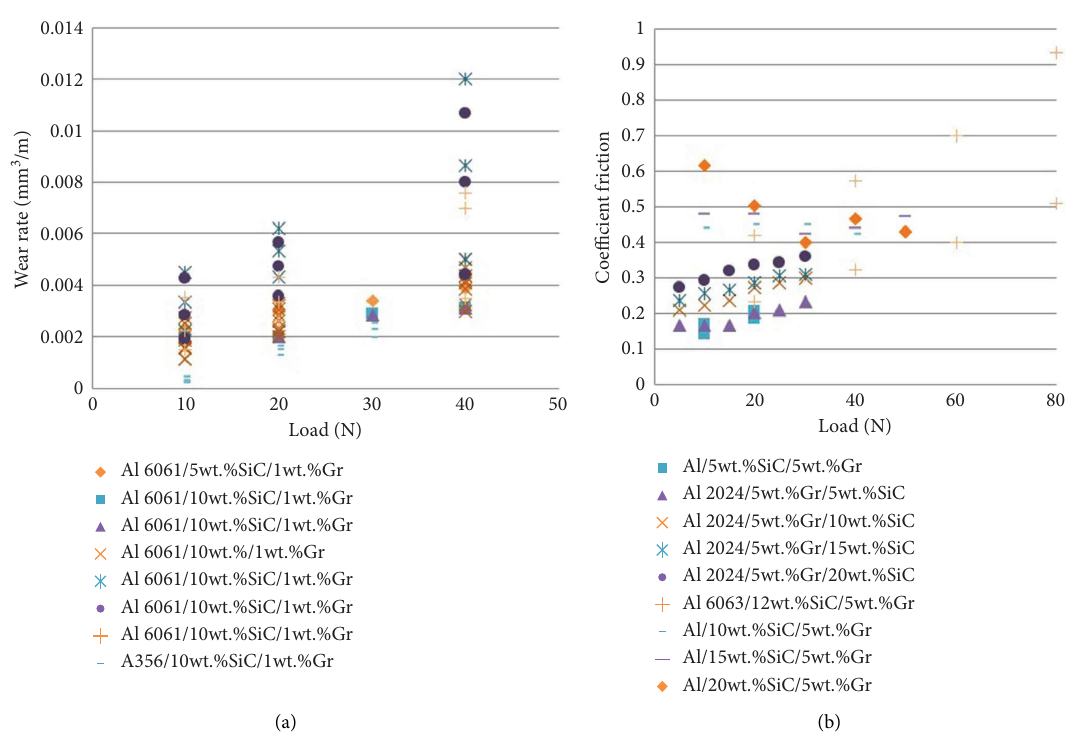
Figure 16: SEM micrographs of (a) monolithic (pure Al) and (b) Al-6 wt% Al [112], copyright 2018, JSR.